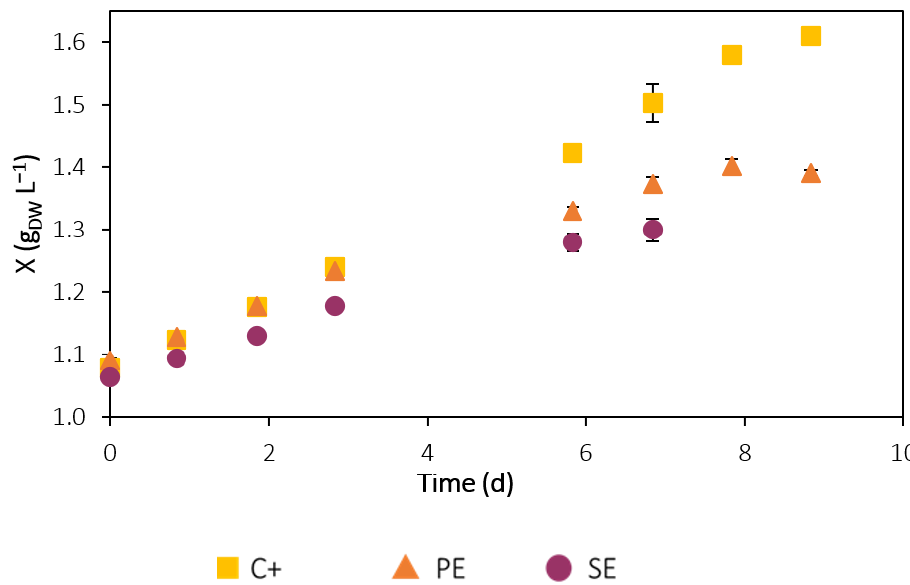
Figure 3. Chlorella vulgaris growth curves obtained for the C+, PE, and SE assays. Error bars correspond to the standard deviation of the mean obtained from two independent experiments.